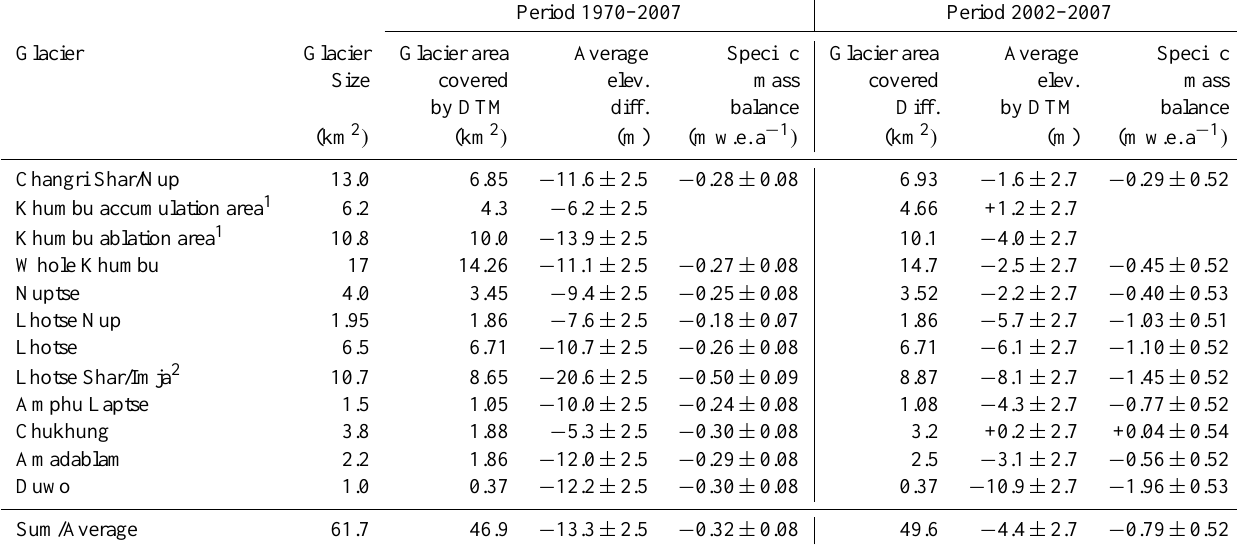
by DTM (km 2 ) (km 2